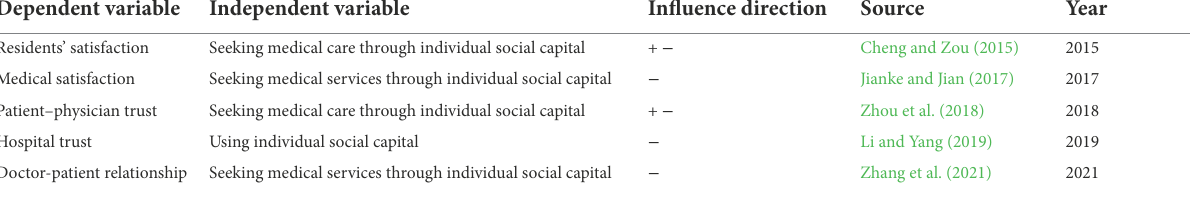
TABLE 1 The role of individual social capital on the related indicators of RSMS in previous